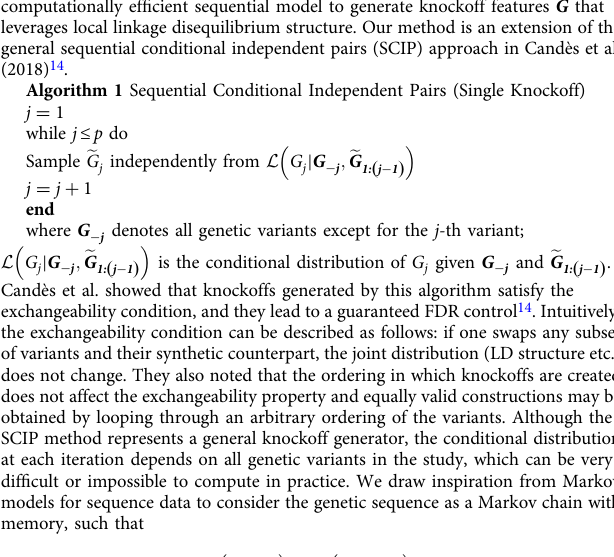
Algorithm 2 Sequential Conditional Independent Tuples (Multiple Knockoffs) j ¼